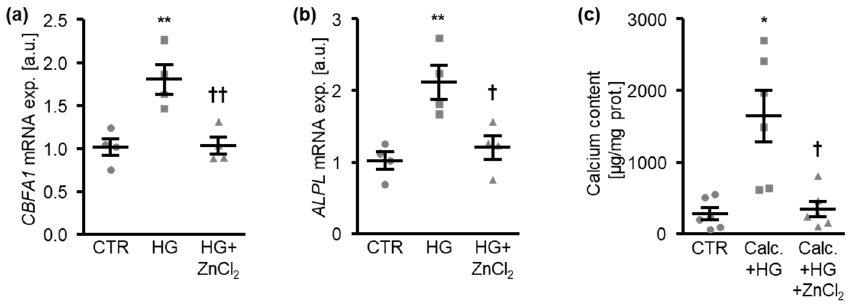
Figure 3. Zinc chloride inhibits osteogenic marker expression and the calcification of HAoSMCs in- duced by high levels of glucose. ( a , b ). Relative mRNA expression of CBFA1 ( a ) and ALPL ( b ) ( n = 4; arbitrary units, a.u.) in HAoSMCs treated for 24 h with control (CTR) or high glucose levels (HG) in the absence and presence of ZnCl 2 . ( c ). Calcium content ( n = 6, µg/mg protein) in HAoSMCs treated for 11 days with control (CTR) or calcification medium (Calc.) and high glucose levels (HG) in the absence and presence of ZnCl 2 . * ( p < 0.05), ** ( p < 0.01) significant difference versus control group; † ( p < 0.05), †† ( p < 0.01) significant difference versus the HG-/Calc.+HG-treated